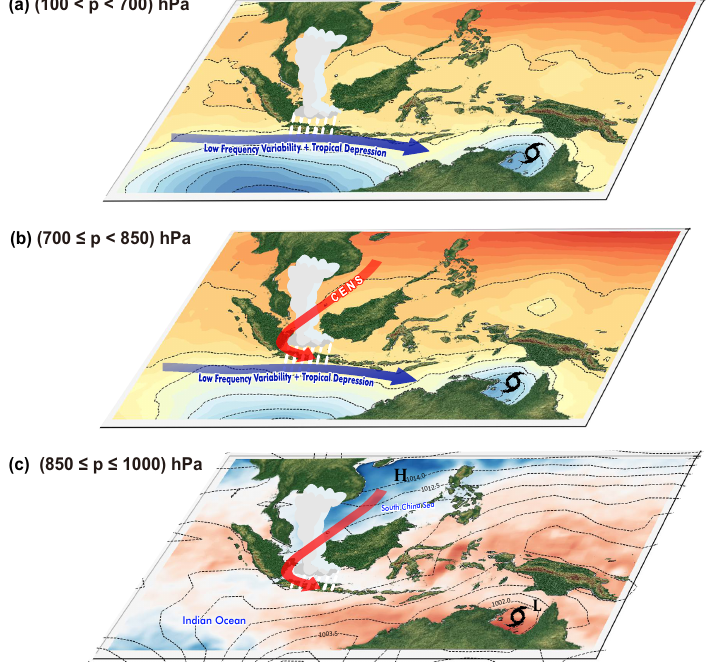
Figure 10. A schematic diagram of large-scale meteorological drivers behind the extreme precipitation during the Semarang Flood Event, 5 to 6 February 2021 at ( a ) (100 < p < 700) hPa, ( b ) (700 ≤ p < 850) hPa, and ( c ) (850 ≤ p ≤ 1000) hPa. Color shading and contour line in ( a , b ) denotes geopotential height. In ( c ), color shading denotes SST, while the contour line denotes mean sea-level